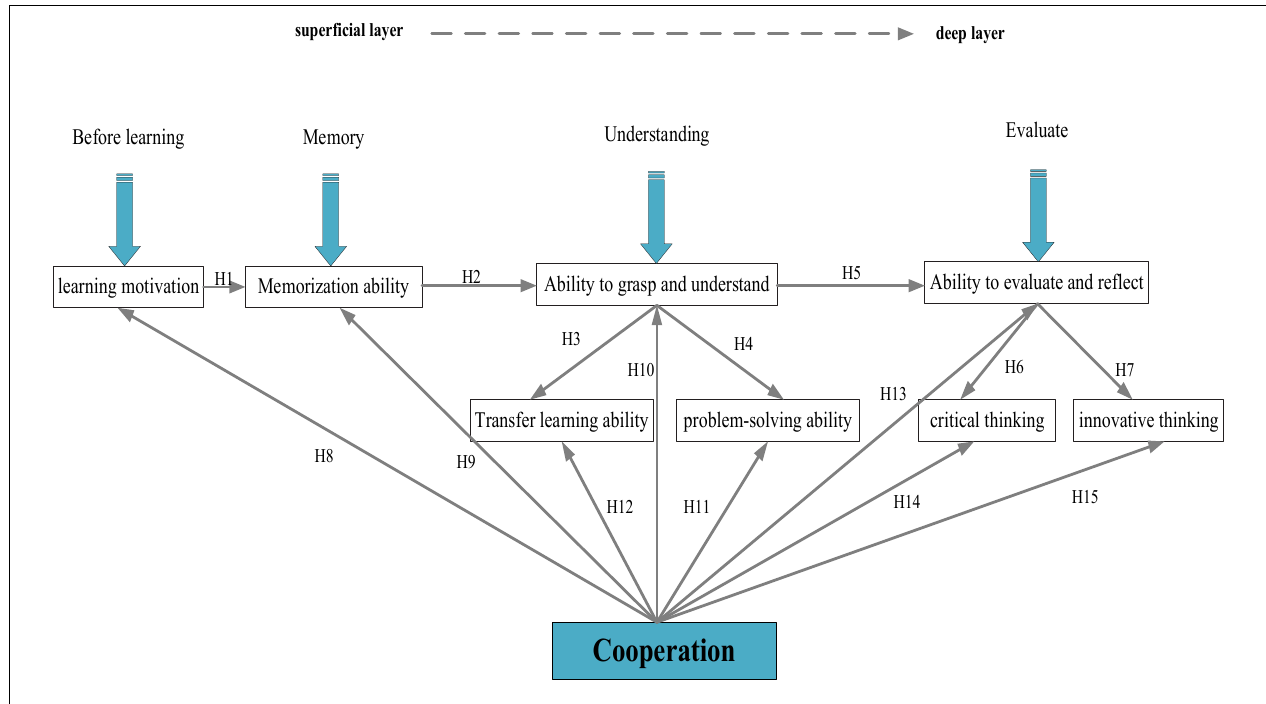
FIGURE 3 | Hypothetical model of UGs’ DL process. DL, deep learning; UG,